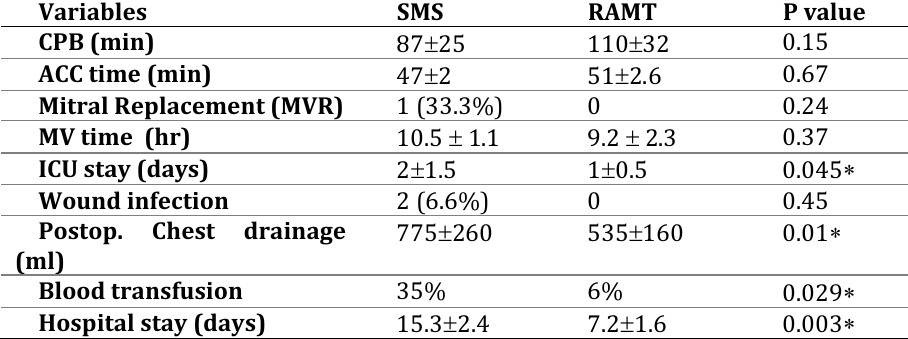
Table 2: Intraoperative variables